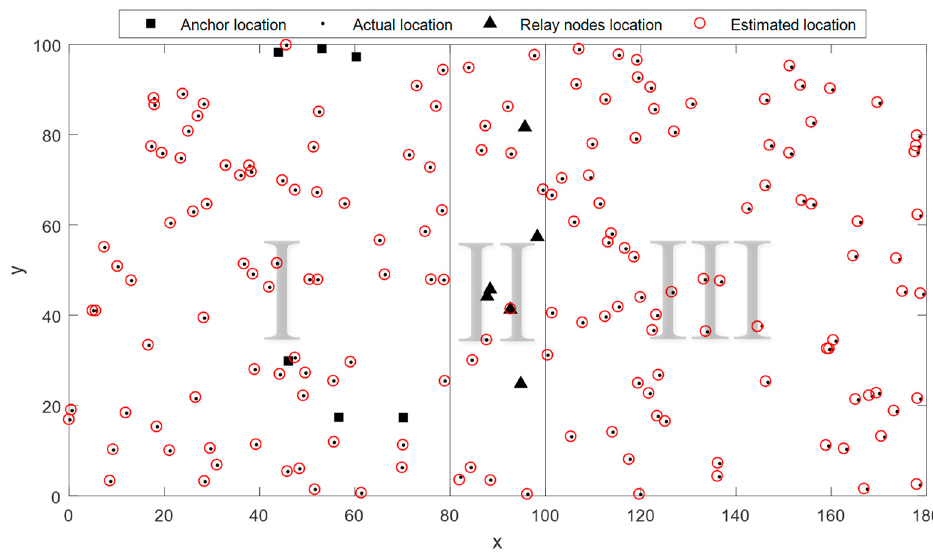
Figure 10. Localization results under large-scale scene scenario with complex noise and anomaly.